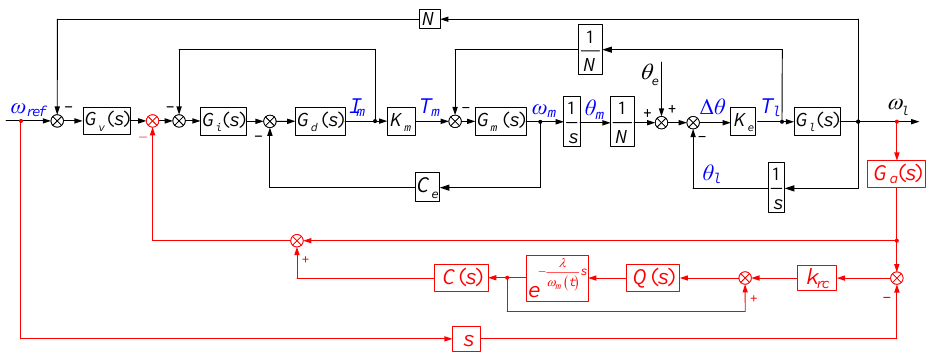
Figure 7. Overall block diagram of the compound control